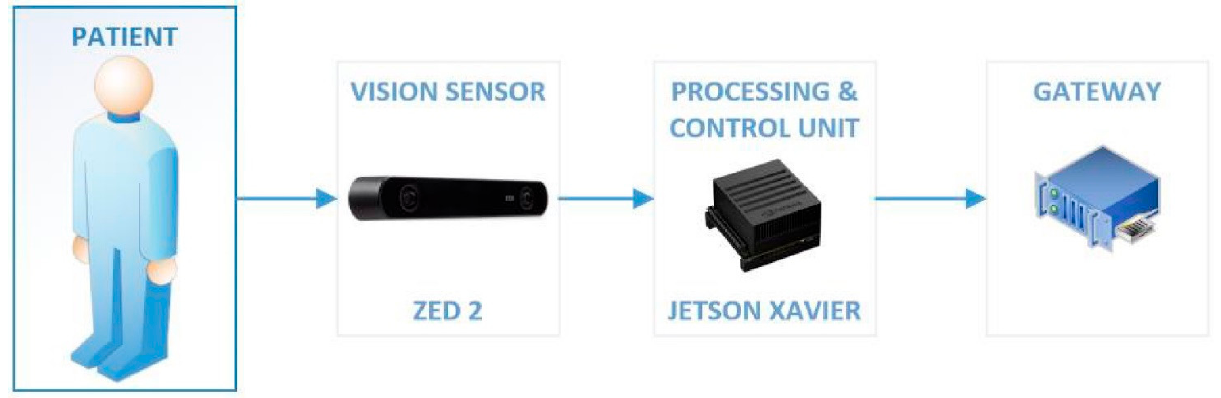
Figure 3. HAR system diagram.